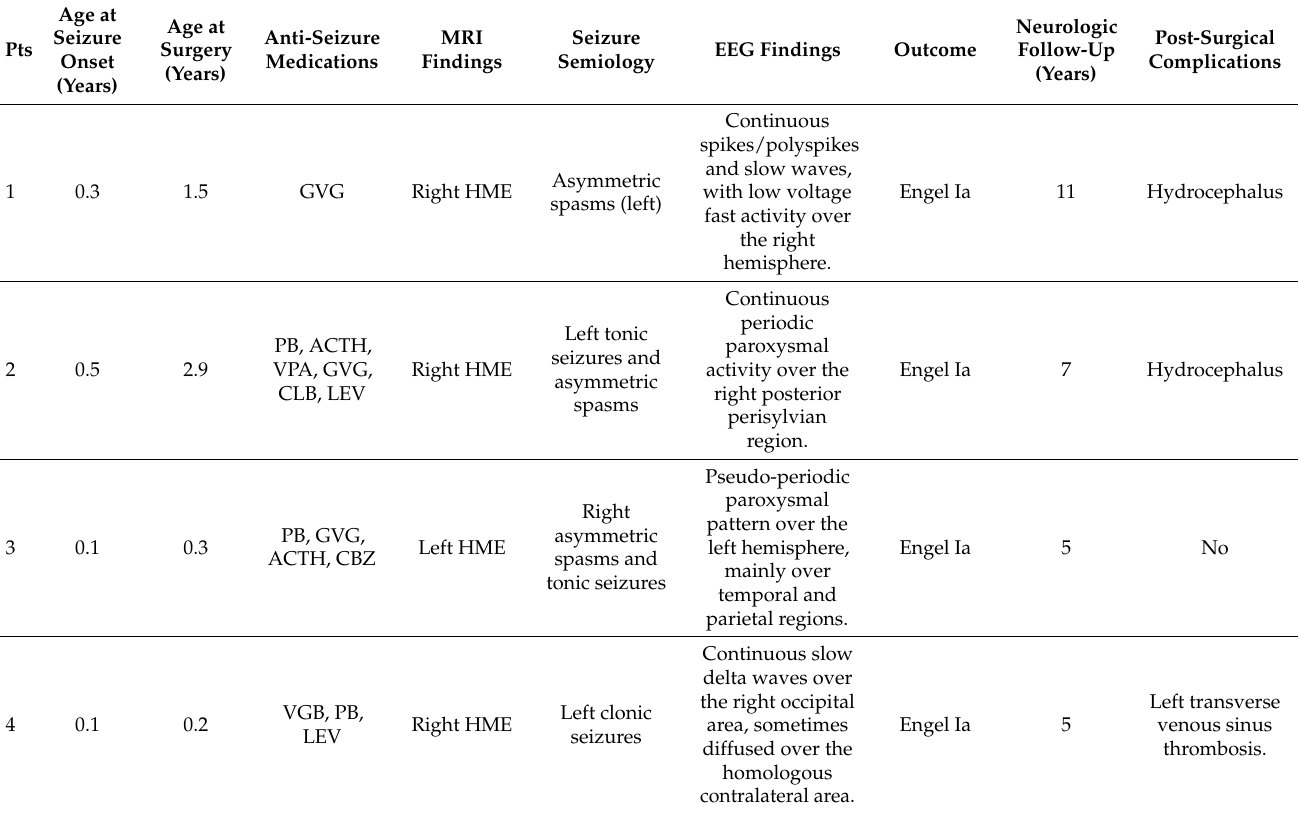
Table 1. Summary of clinical and epileptological patients’